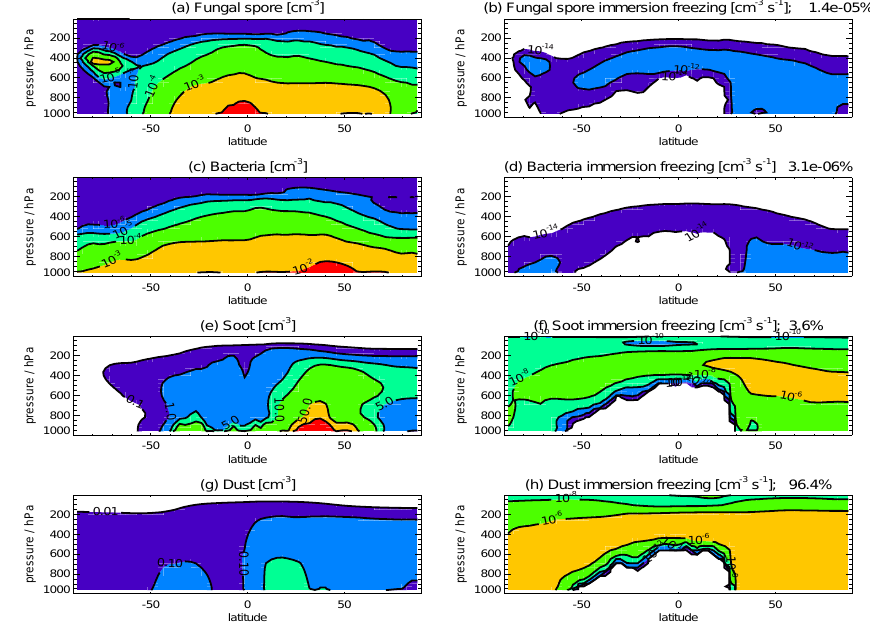
Figure 4. Zonal annual mean number concentrations for (a) fungal spores, (c) bacteria, (e) soot, (g) dust and all-sky immersion freezing rates for (b) fungal spores, (d) bacteria, (f) soot and (h) dust. Note (e) and (g) have a different colour scale to (a) and (c) . Numbers above panel show percentage contribution to annual mean all-sky freezing rate. Weighting by ice-cloud fraction does not greatly change fractional contribution (see